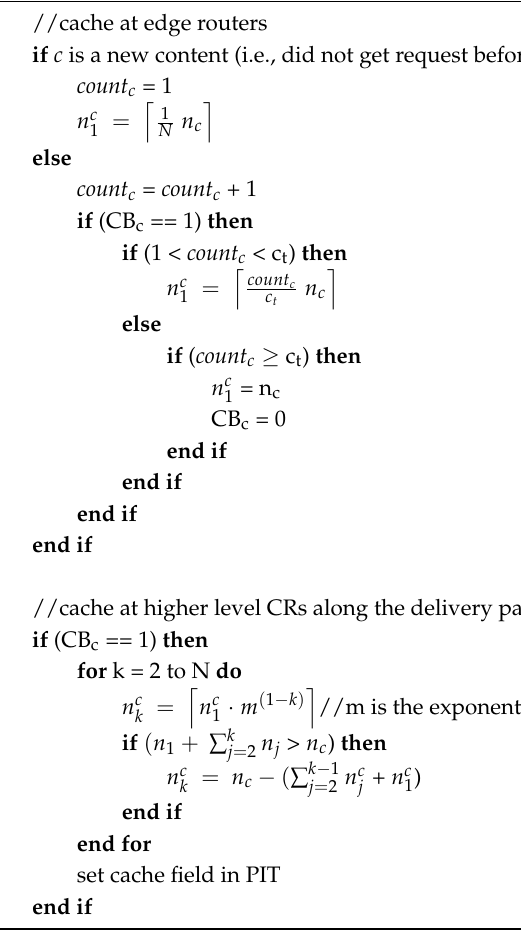
Algorithm 1. Interest packet processing Algorithm